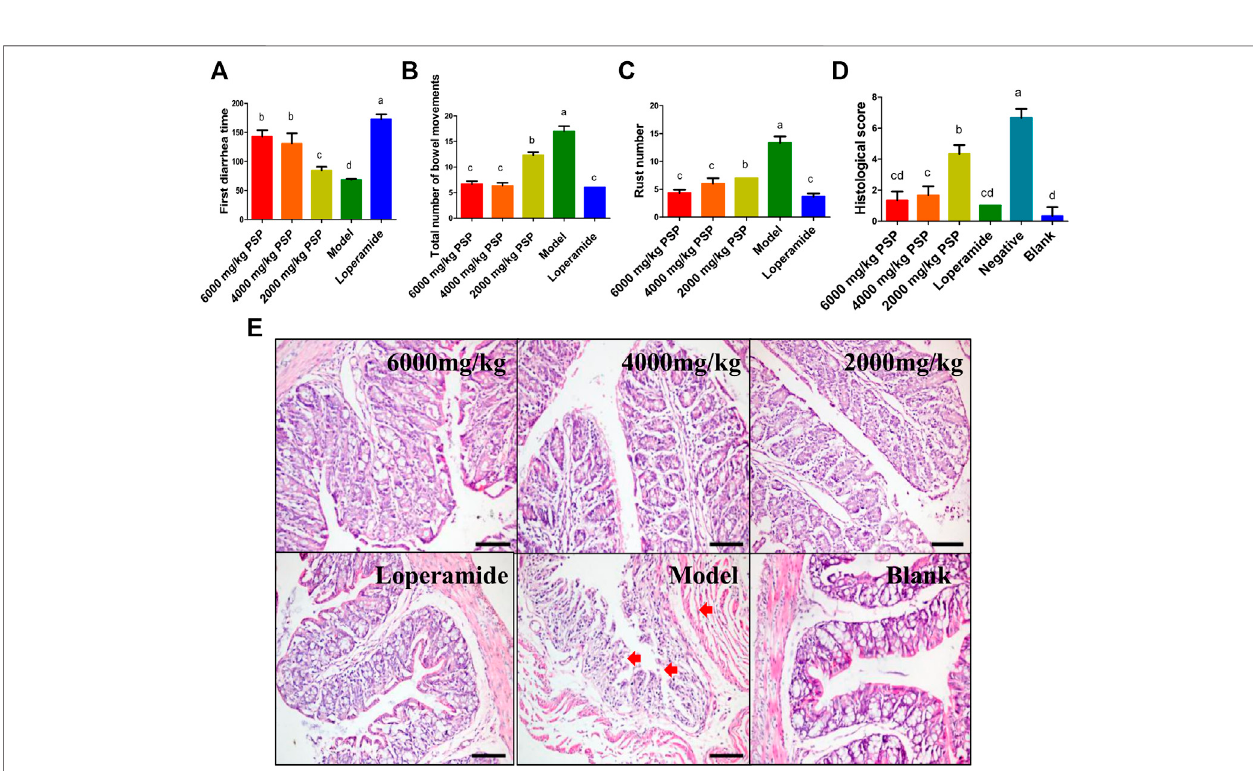
FIGURE 6 | The evaluation of antidiarrhea activities of PSP. (A – C) Three doses of PSP groups were compared with model and positive group. Results are presentedasmeans ± SD.Differentsmalllettersuperscriptsinthesamecolumnindicatesigni fi cantdifferencesat p < 0.05. (D) Thehistologicalscoreofdifferentgroups, a high histological score indicates a serious histological injury. (E) Pathological section of mouse colon tissue. Data are presented as the means ± SD from fi ve groups. Different small letter superscripts in the same column indicate signi fi cant differences at p < 0.05